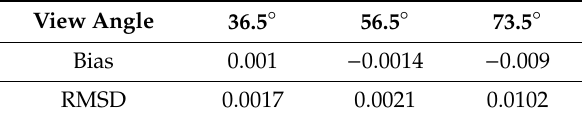
Table 1. The bias and root mean square di ff erence (RMSD) values between the simulated and measured sea surface emissivity